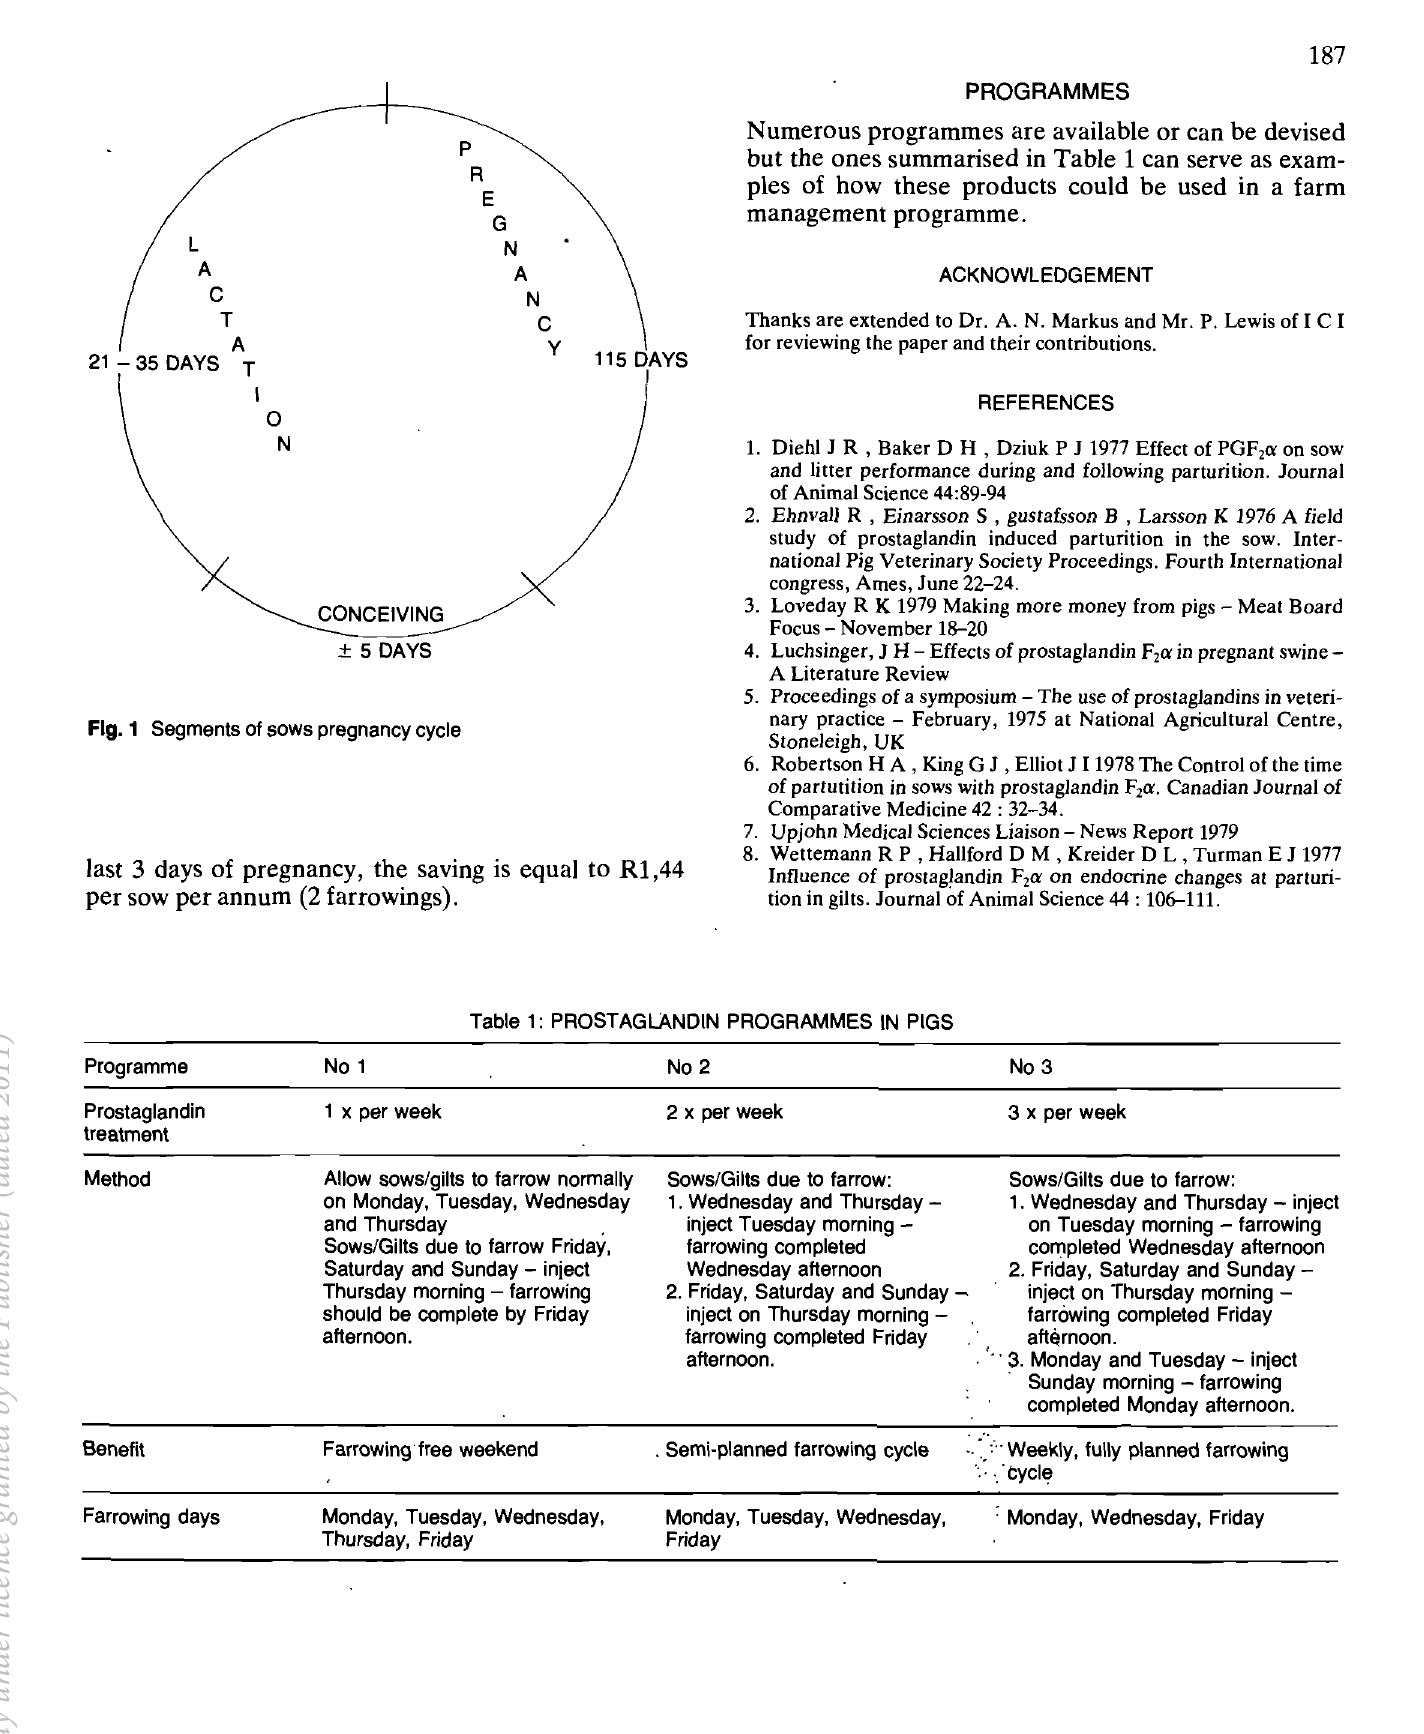
Table 1: PROSTAGLANDIN PROGRAMMES IN